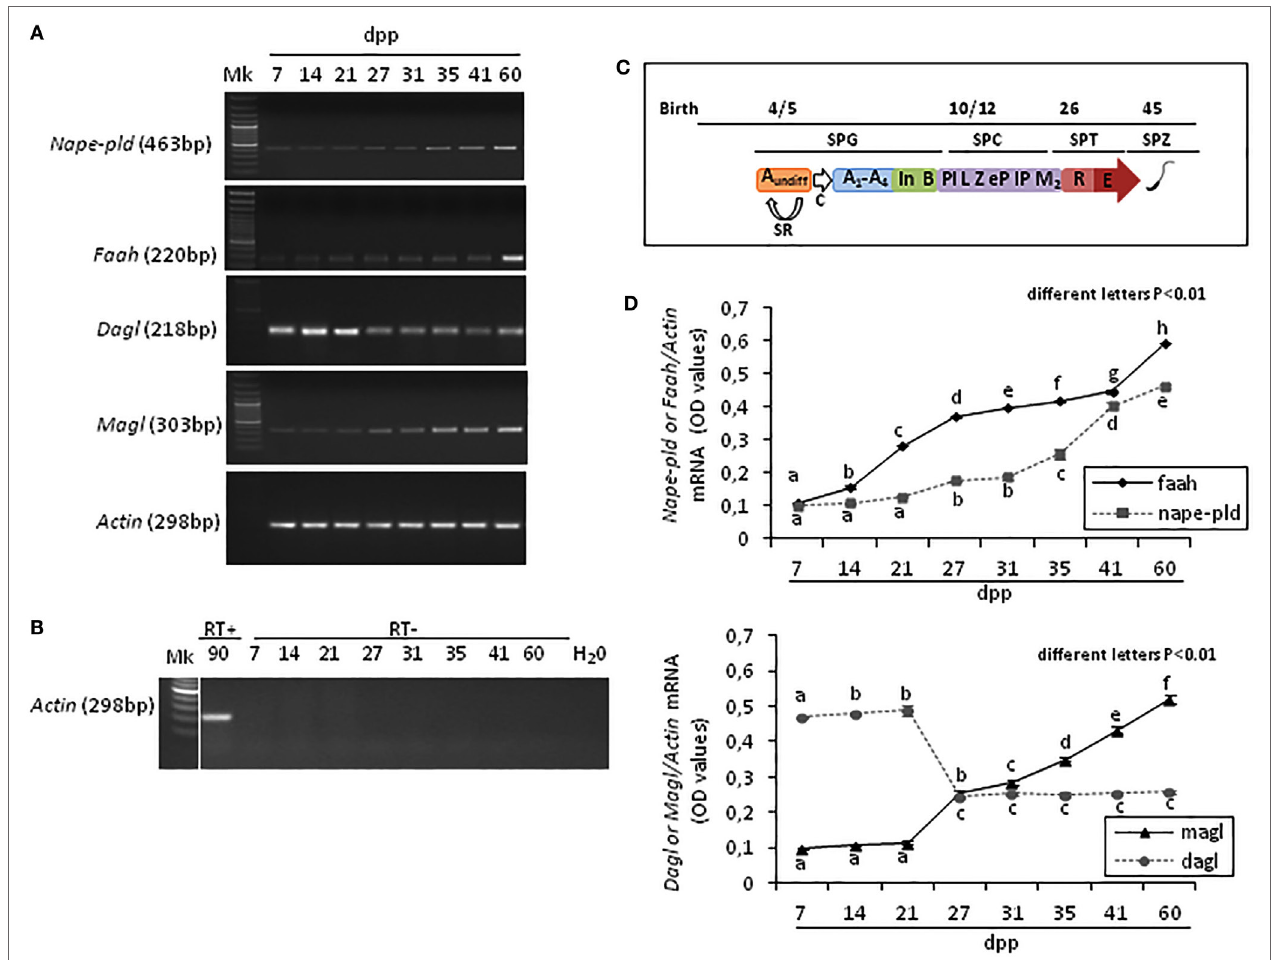
FigUre 1 | RT-PCR analysis of the main AEA and 2-arachidonoylglycerol metabolizing enzymes in rat testis during the first wave of spermatogenesis. Representative images of RT-PCR analyses showing Nape-pld , Faah , Dagl , Magl , and Actin mRNA expression in rat testes from 7 to 60 days post partum ( dpp ) (a) . Representative agarose gel image of RT + cDNA (testes from 90 dpp rats), RT − cDNA (testes from 7 to 60 dpp rats) and water (H 2 O) analyzed by PCR using actin primers (B) . Gene expression was quantified by densitometry analysis and graphed relatively to germ cells appearance or activities (c) . Values for Nape-pld , Faah , Dagl , and Magl signals were normalized against Actin and are expressed as OD values (D) . All data are expressed as the mean ± SEM. Different letters indicate statistically significant differences ( p < 0.01). Abbreviations: SPG, spermatogonia; SPC, spermatocytes; SPT, spermatids; SPZ, spermatozoa; A undiff , undifferentiated- SPG; A 1 -A 4 , differentiating type-A 1 -A 4 SPG; In, differentiating intermediate-SPG; B, differentiating type-B SPG; Pl, preleptotene SPC; L, leptotene SPC; Z, zygotene SPC; eP, early pachytene SPC; lP, late pachytene SPC; M 2 , secondary SPC; R, round SPT; E, elongated SPT; SR, self-renewal; C,